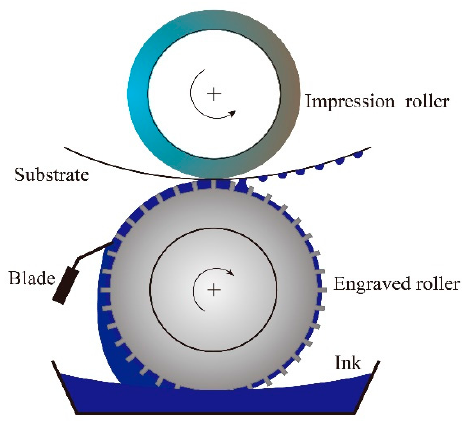
Figure 1. Schematic diagram of gravure printing process.